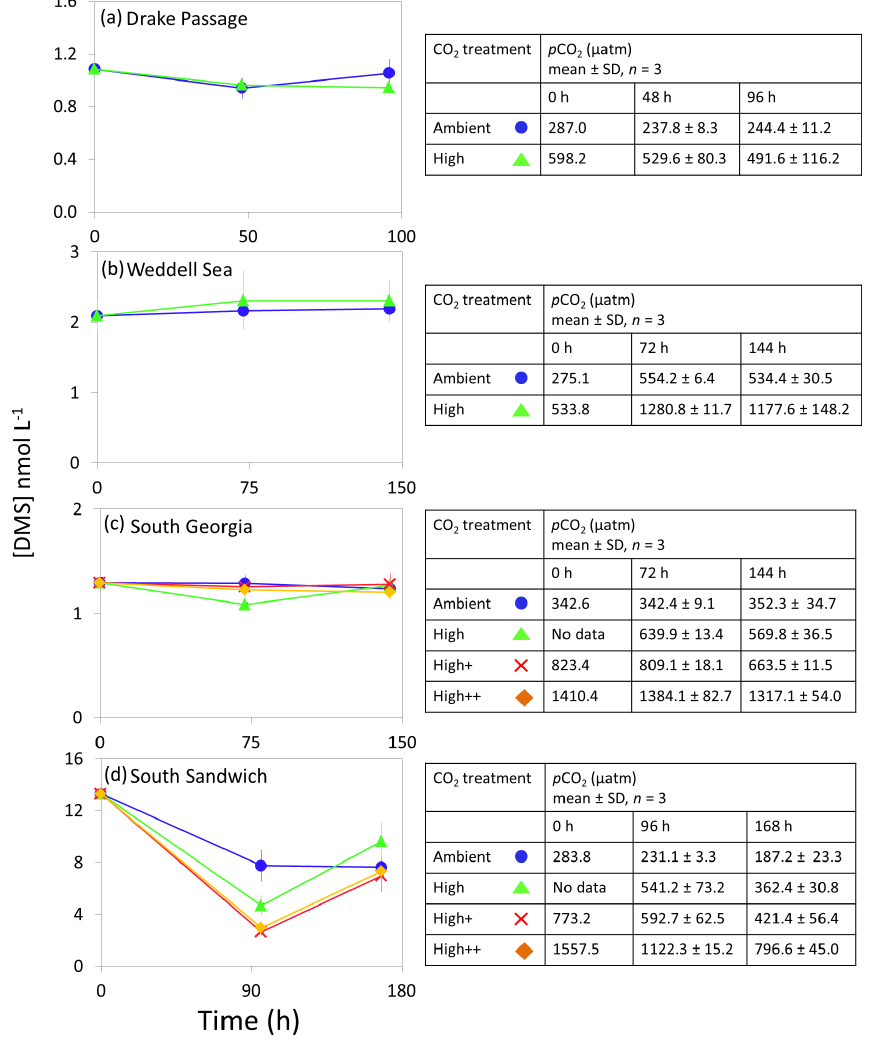
Figure 4. DMS concentrations (nmolL − 1 ) during experimental microcosms performed in Southern Ocean waters. Data shown are the mean of triplicate incubations, and error bars show the standard error on the mean. Tables show measurements of p CO 2 (µatm) for each treatment at each sampling time point. Initial measurements (0h) were from a single sample, whilst measurements at 48 and 96h show mean ± SD of triplicate experimental bottles. Locations of water collection for microcosms shown in Fig.